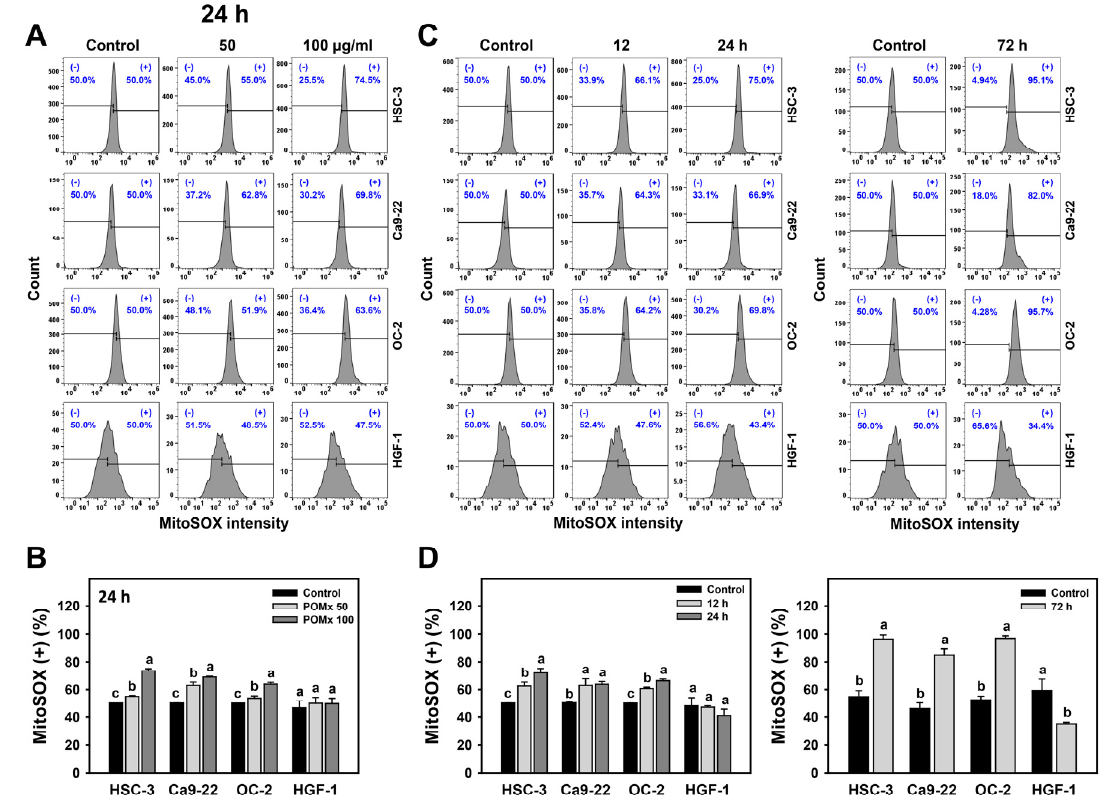
Figure 6. MitoSOX generation of oral cancer cells after POMx incubation. ( A ) Dose-response to MitoSOX flow cytometry patterns. Cells (HSC-3, Ca9-22, and OC-2) were incubated with 0, 50, and 100 µ g/mL of POMx (control, POMx 50, and POMx 100) for 24 h. The MitoSOX (+) population was defined in the right part. ( B ) Statistics for ( A ). ( C ) Time course to MitoSOX flow cytometry patterns. Cells were incubated with control and 100 µ g/mL of POMx for 0, 12, 24, and 72 h. ( D ) Statistics for ( C ). Treatments without overlapping low cases (a to c) show significant differences for the same cell lines. p < 0.05. Data, mean ± SD ( n = 3).